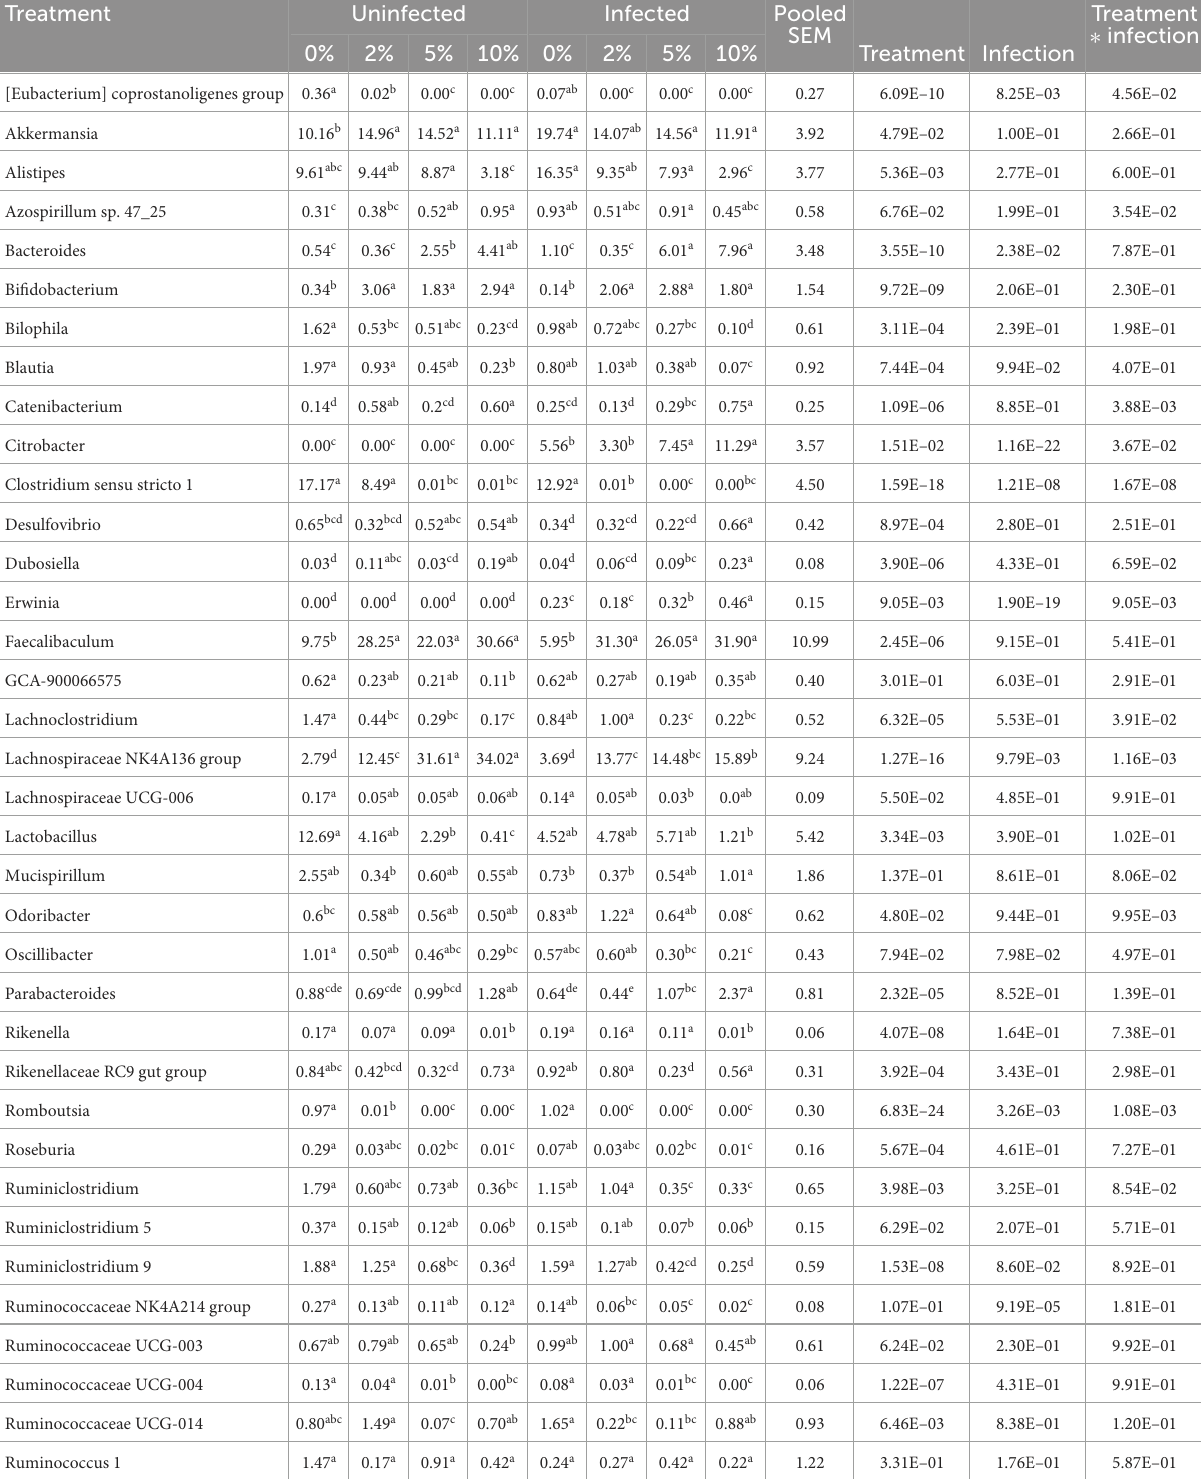
TABLE 2 Effect of diet and C. rodentium infection on various genera with relative abudance above 0.1% from feces obtained from uninfected and infected mice at day 6 post-infection 1 .